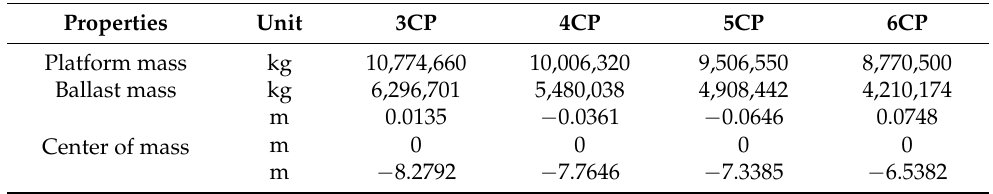
Table 6. Platform properties.